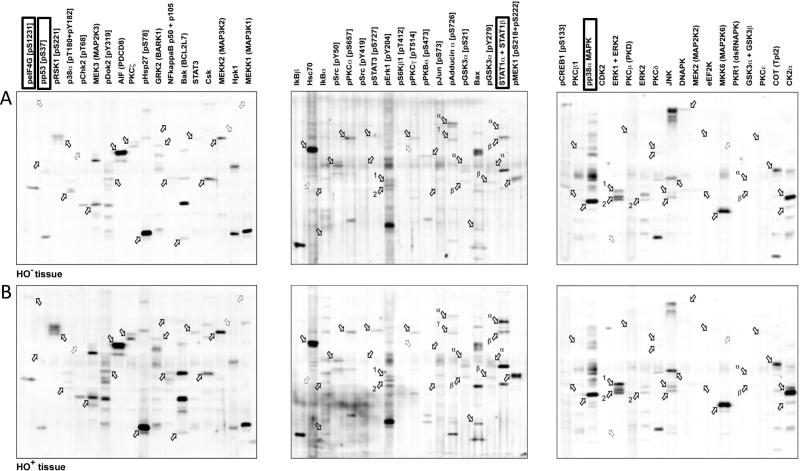
Western blot analysis to identify biomarkers from tissue samplesPooled HO− (A) or HO+ (B) tissue samples were tested for differential expression of 54 targets selected from semi-quantitative antibody arrays. Dark outlined arrows indicate the expected positions of the target proteins detected by their respective antibodies, whereas light outlined arrows indicate the migration positions of target proteins that were not visualized.